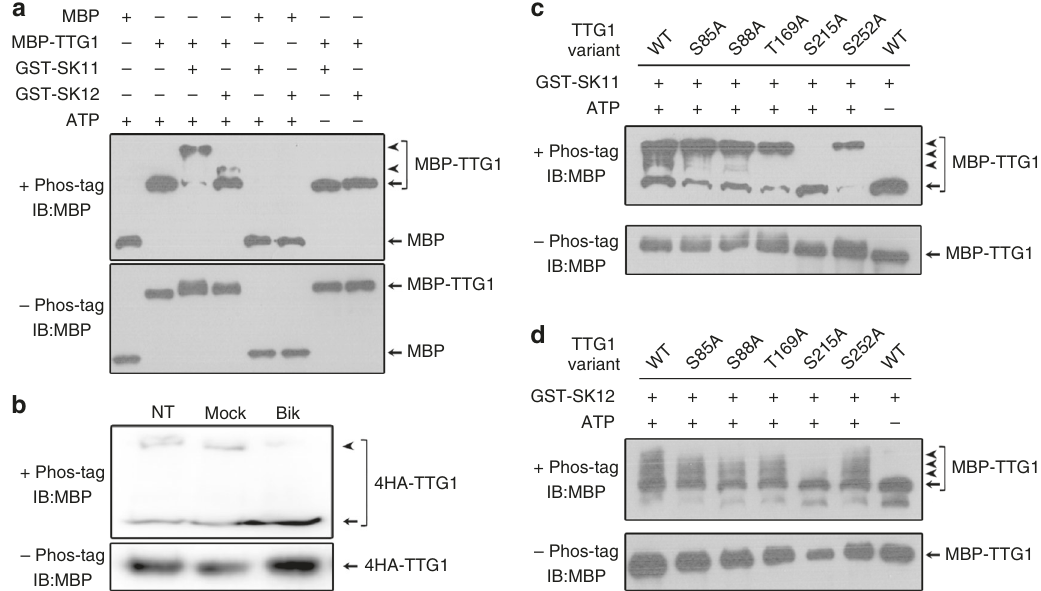
Fig. 4 SK11 and SK12 phosphorylate TTG1 mainly through Ser 215. a GST-SK11 and GST-SK12 alter the electrophoretic mobility of MBP-TTG1 on a Phos-tag- containing gel (upper panel), but not on a regular SDS-PAGE gel (lower panel). GST-SK11 and GST-SK12 do not affect the electrophoretic mobility of MBP on both Phos-tag-containing and regular SDS-PAGE gels. Arrowheads and arrows indicate phosphorylated and unphosphorylated protein forms, respectively. b Bikinin treatment inhibits phosphorylation of 4HA-TTG1 in ttg1-13 g4HA-TTG1 . Total protein was extracted from ttg1-13 g4HA-TTG1 siliques collected at 4 days after pollination, which were not treated (NT), mock-treated (Mock), or treated by bikinin (Bik) for 2 h. These protein extracts were analyzed by immunoblot on Phos-tag-containing (upper panel) and regular SDS-PAGE (lower panel) gels using anti-MBP antibody. Arrowhead and arrow indicate phosphorylated and unphosphorylated 4HA-TTG1, respectively. c , d Immunoblot analysis of phosphorylation of MBP-TTG1 variants containing single site mutations at serine or threonine by GST-SK11 ( c ) or GST-SK12 ( d ) on Phos-tag-containing (upper panels) and regular SDS-PAGE (lower panels) gels. In vitro phosphorylation of wild-type TTG1 (MBP-TTG1) with or without ATP serves as a positive or negative control, respectively. Arrowheads and arrows indicate phosphorylated and unphosphorylated MBP-TTG1, respectively. Uncropped original scans of immunoblots are shown in Supplementary Fig. and SK11:SK11 E292K -GFP (Fig. 3g, right panel) both revealed a maternal effect of SK11 or SK12 on fatty acid levels in seeds, indicating that SK11 and SK12 maternally regulate seed characters.